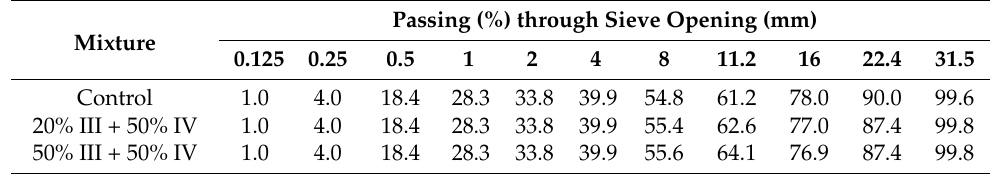
Table 4. Particle size distribution of aggregates used for concrete